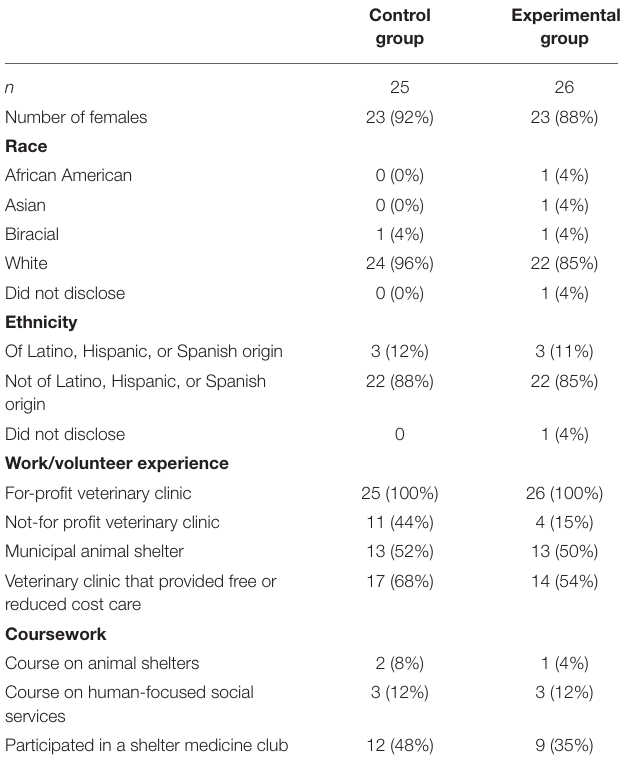
TABLE 4 | Description of study participants.